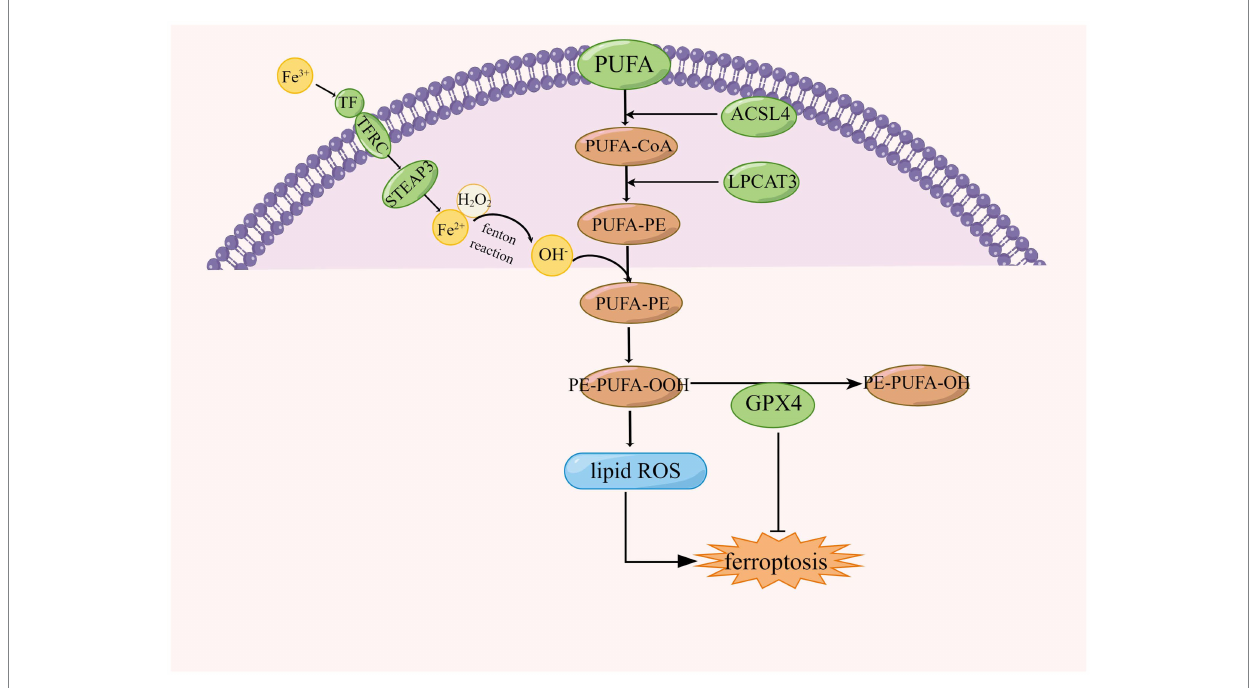
FIGURE 4 Regulation of lipid peroxidation in ferroptosis, ACSL4, acyl-coenzyme A synthase long chain family member 4; LPCAT3, lysophosphatidylcholine acyltransferase 3; CoA, coenzyme A; GPX4, glutathione peroxidase 4; and PUFA, polyunsaturated fatty